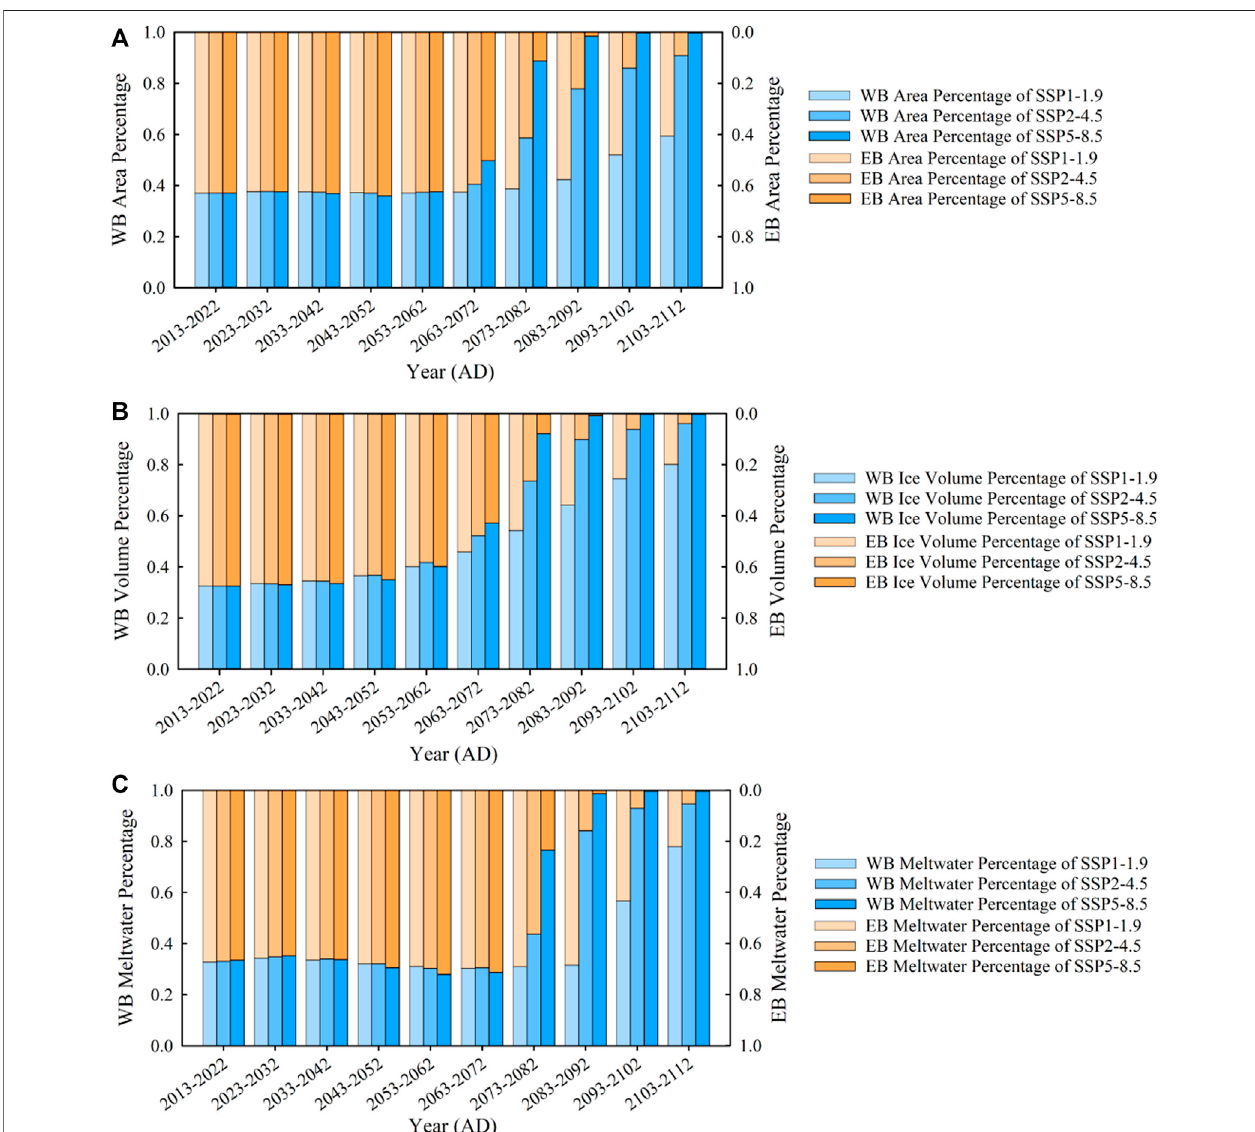
FIGURE 15 | The (A) area, (B) ice volume, and (C) meltwater percentage of the EB (WB) to the entire glacier in the three climate scenarios.